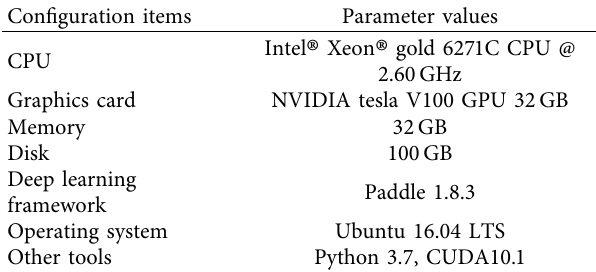
Table 2: Experimental